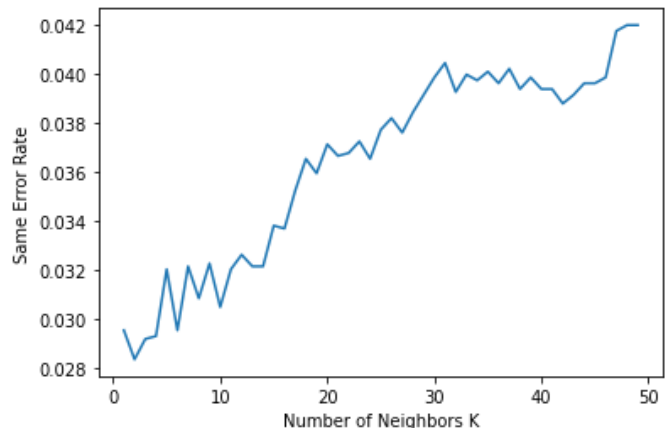
Figure 9. Linear growth of same error rate in KNN algorithm.